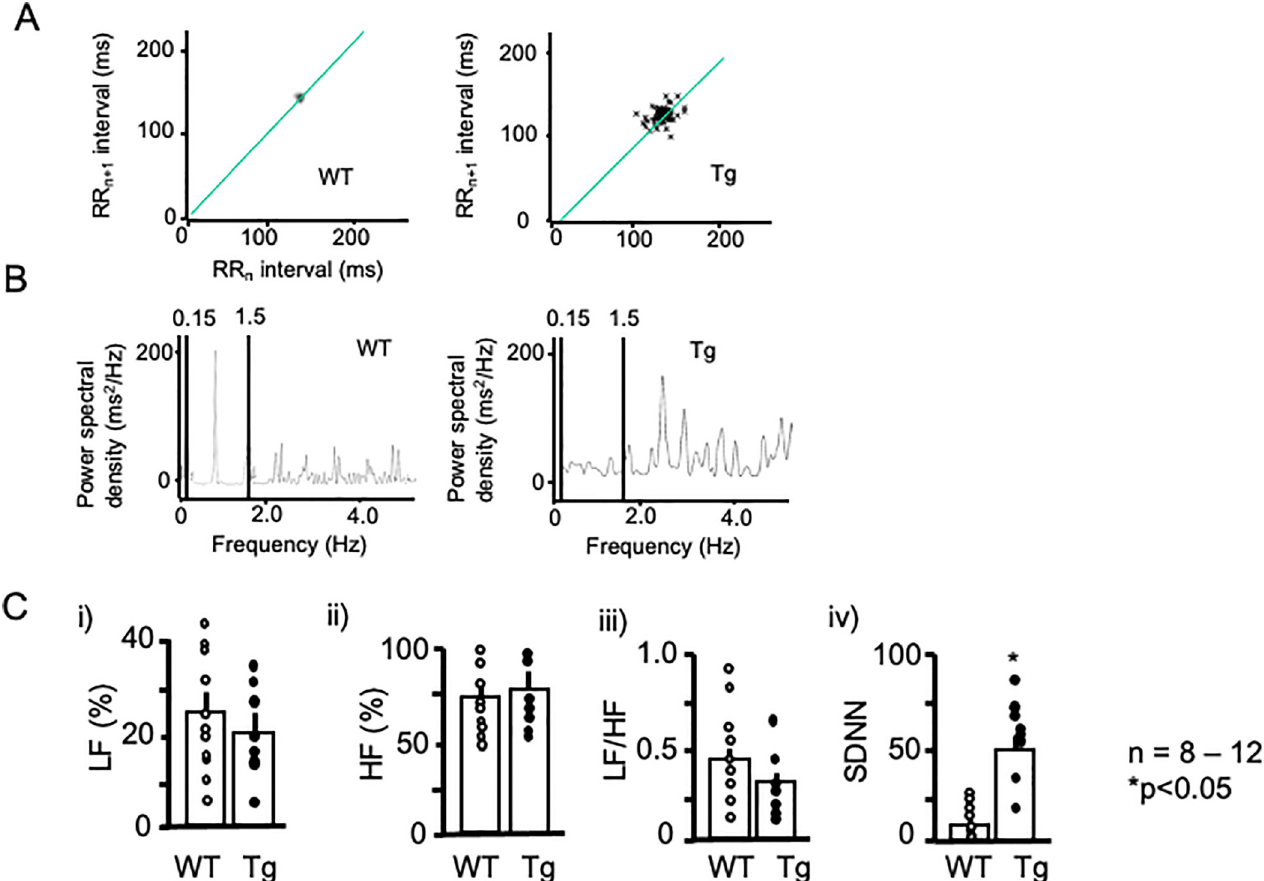
Fig 3. HRV analysis. A) Representative ECG Poincaré plots of WT (left panel) and Tg mice (right panel). Poincaré plots (RRn vs. RRn+1) in which consecutive pairs of R-R intervals during the control period were plotted with the nth+1 R-R interval against the nth R-R period. Note the marked scattering in Tg mice. B) Representative power spectral analysis of WT (left panel) and Tg mice (right panel). C) Statistical analysis of the power spectra (i–iii). LF (i) and HF (ii) components, LF/HF (iii), and SDNN of WT (open circles) and Tg mice (filled circles) are shown. � P < 0.05 vs. WT. Each group consisted of at least six samples. Error bars indicate the standard error of the